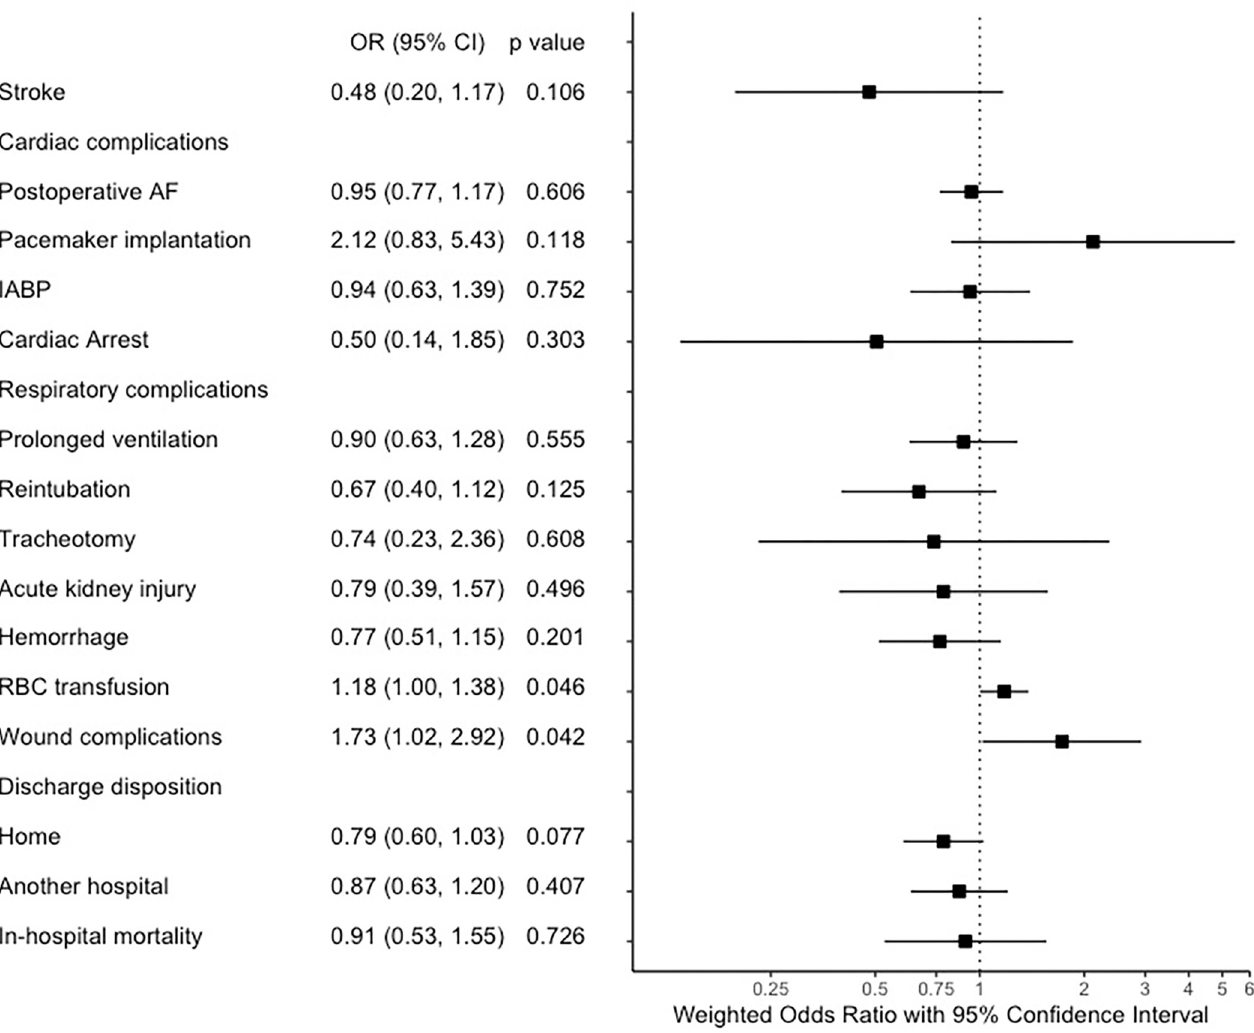
Fig 4. Odds ratio plot. Overlap weighted outcome analysis: male vs